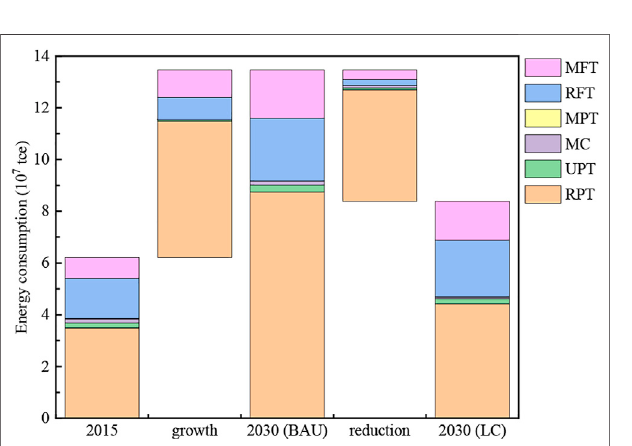
FIGURE9| CO 2 emission reduction ofdifferentmodes oftransportation in Guangdong Province. Note marine freight transport (abbreviated as MFT); road freight transport (abbreviated as RFT); marine passenger transport (abbreviated as MPT); motorcycle (abbreviated as MC); urban public transport (abbreviated as UPT); road passenger transport (abbreviated as